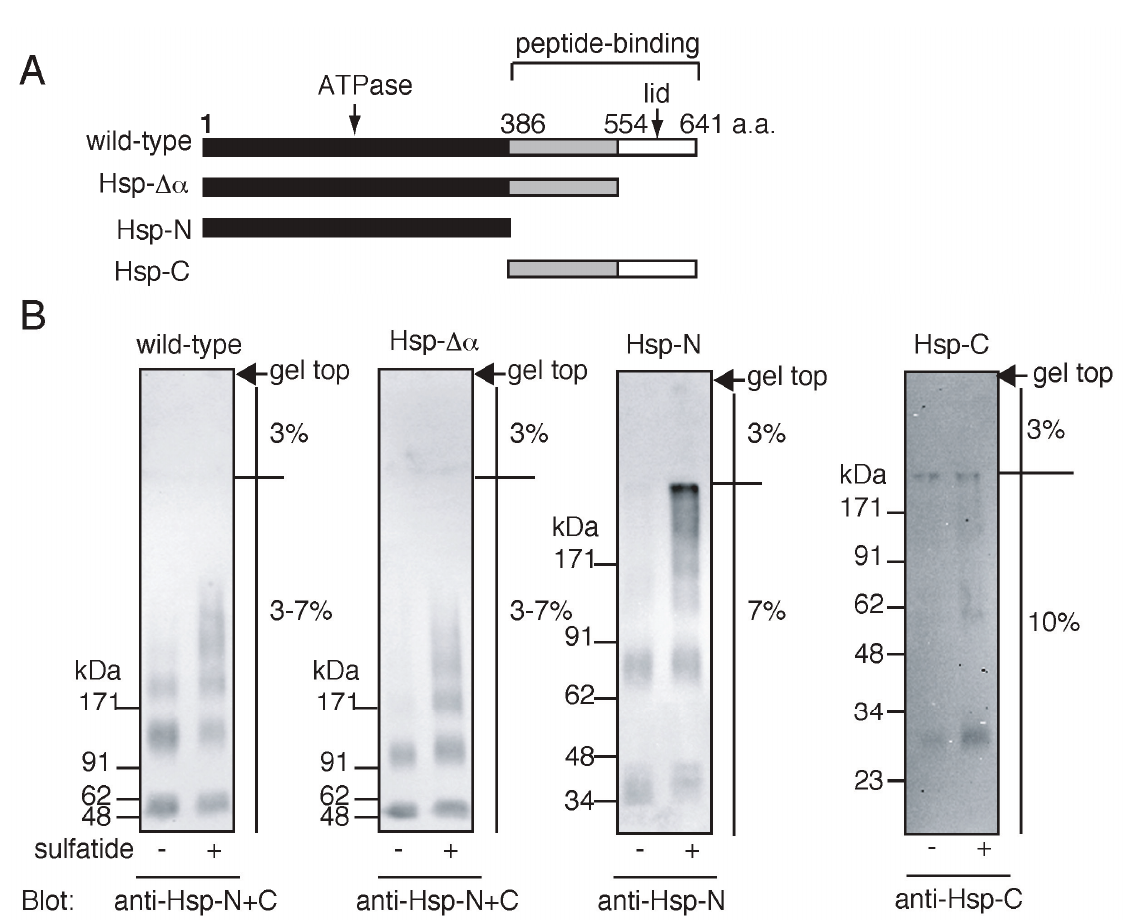
Figure 2. The ATPase domain of Hsp70 mediates sulfatide-induced oligomerization of Hsp70. ( A ) Schematic representation of wild-type and truncation mutants of Hsp70. Hsp70-(cid:3)(cid:4), Hsp70-N and Hsp-C lack the lid domain, the peptide-binding domain and the ATPase domain, respectively. The number of amino acid residues (a.a.) were indicated on the scheme; ( B ) Hsp70 was incubated with (+) or without ((cid:5)) sulfatide, cross-linked